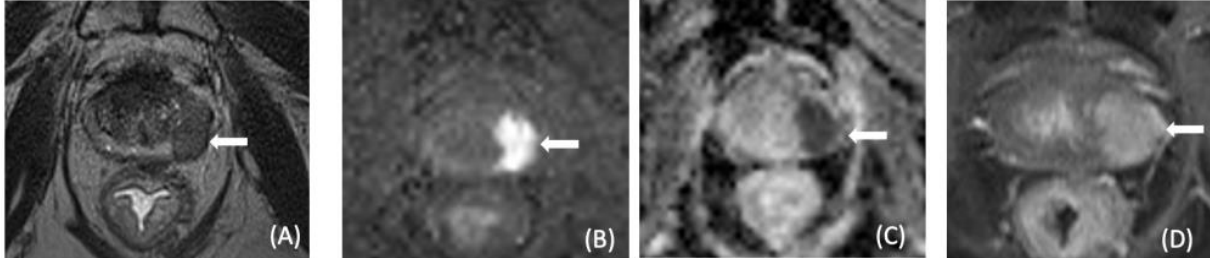
Figure 2. A 77-year-old male with serum PSA = 7 ng/mL after RTE. Axial T2 W MRI ( A ), DW MR( B ), ADC map of DW MR ( C ), and DCE MRI ( D ) show a lesion in the left part of the peripheral zone (arrows). Targeted biopsy revealed Gleason 3 + 4 recurrent prostate cancer.